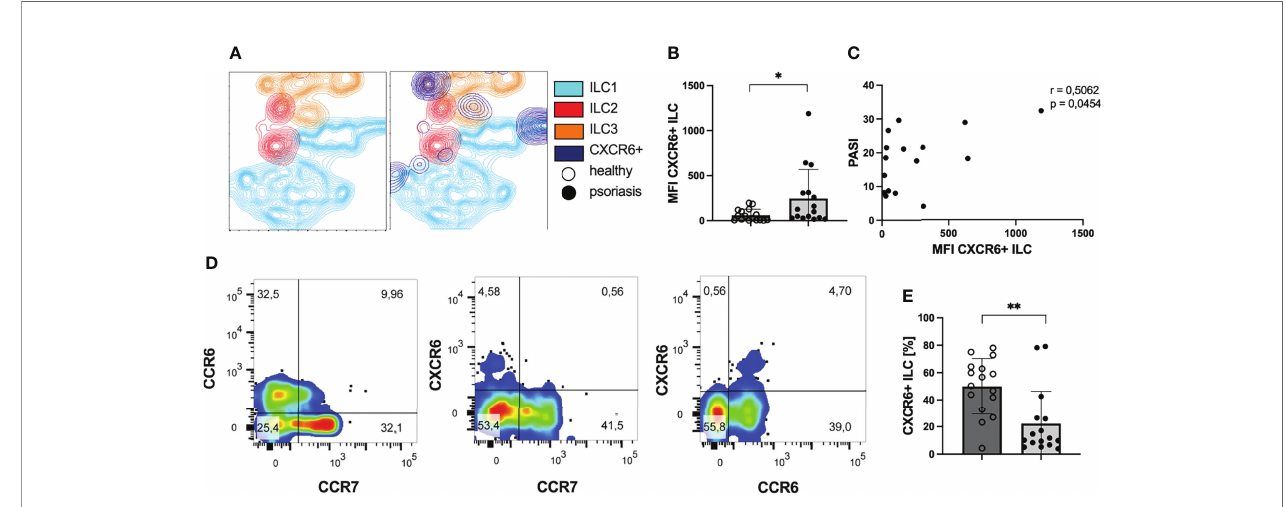
FIGURE 4 | ILCs express CXCR6 in patients with psoriasis. (A) T-SNE contour plot presenting the clustering of ILCs in subgroups ILC1 (blue), ILC2 (red) and ILC3 (orange) and their expression of the chemokine receptor CXCR6 (dark blue). There are subgroups of ILC1 and ILC3 expressing the receptor CXCR6. (B) Flow cytometry analysis of MFI of CXCR6 expression on peripheral ILCs of psoriatic patients (n=16) and healthy volunteers (n=16), mean and SD, Welch t test. (C) Correlation of MFI of the receptor CXCR6 and the clinical skin involvment (n= 16), Pearson correlation. (D) Coexpression of chemokine receptors CXCR6, CCR6 and CCR7 among all ILCs. (E) Mean and SD of percentage of CXCR6 expressing ILCs among all ILCs of healthy volunteers (n=16) and psoriatic patients (n=16), Mann-Whitney test. *p < 0.05; **p <